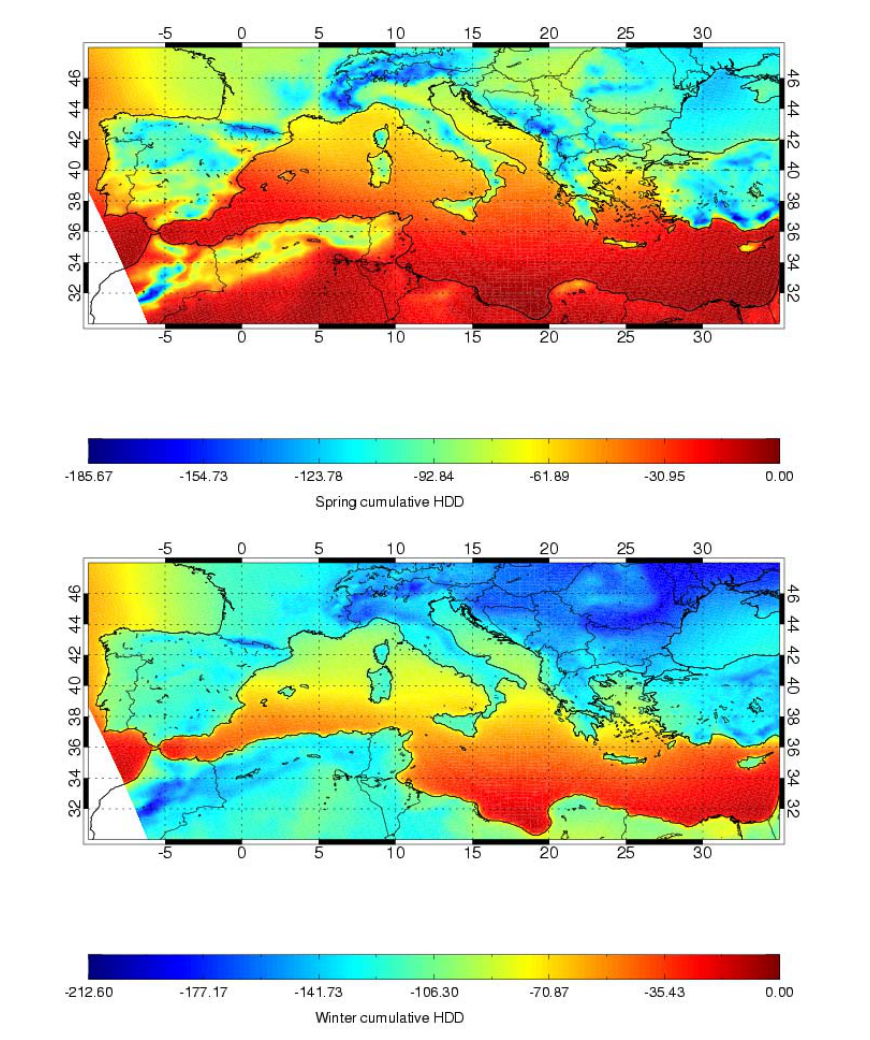
Figure 4. Changes in spring (top) and winter (bottom) cumulative HDD between future and control